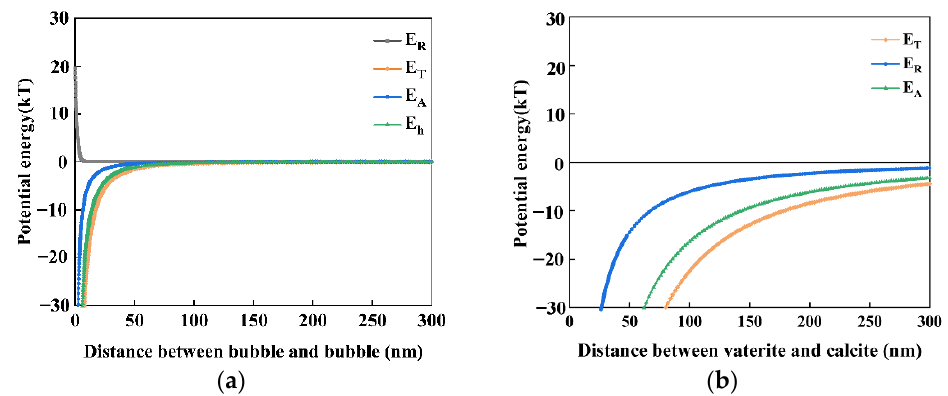
Figure 12. ( a ) Total potential energy E T between bubbles (700 nm, − 15 mV) as a function of the distance between two bubbles by the extended DLVO theory, at a Na + concertation of 0.05 M and a Ca 2+ concentration of 2 × 10 − 5 M; ( b ) Total potential energy E T between calcite (3 µ m, − 10 mV) and vaterite (6 µ m, 20 mV) as a function of the distance between two particles by the classical DLVO theory, at a Ca 2+ concentration of 2.5 × 10 − 5 M.